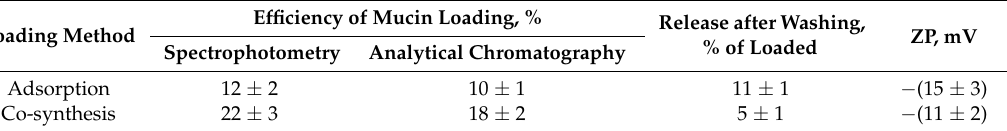
Table 1. Characteristics of the incorporation of commercial mucin (1 mg mL − 1 ) into the CaCO 3 crystals (20 mg mL − 1 ).